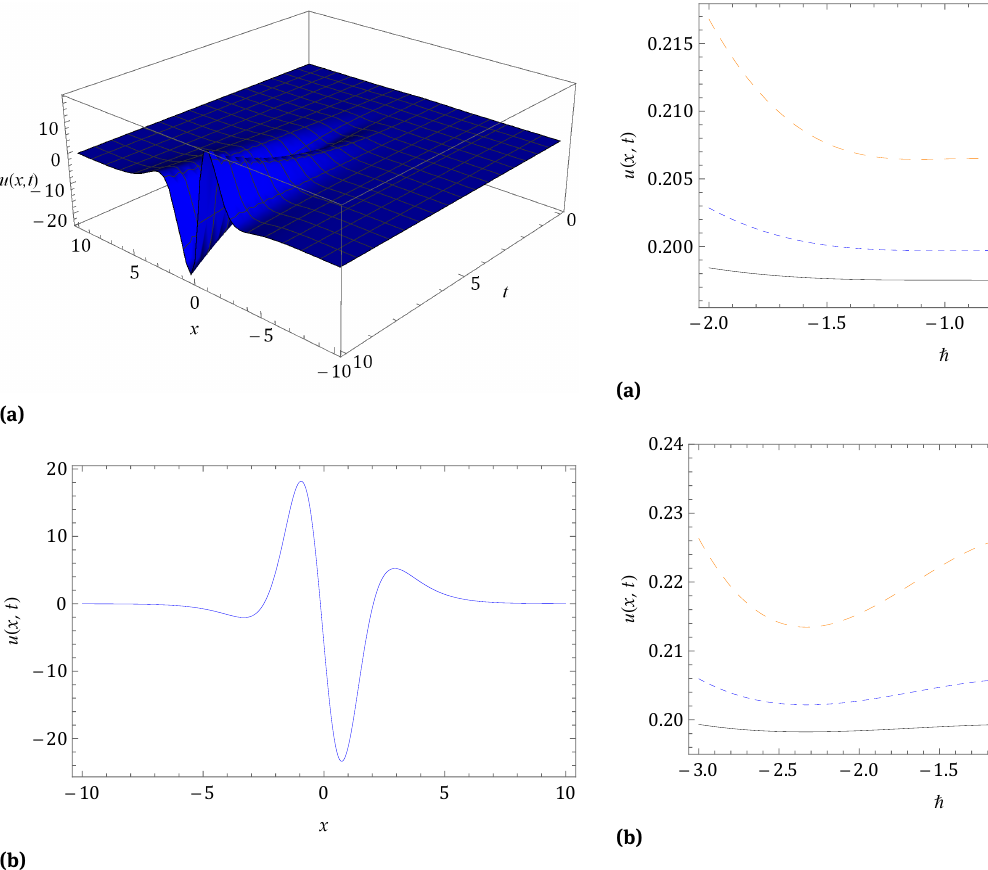
Figure 4: (cid:125) -curves for q -HATM solution with distinct α at x = 1 and t = 0.01 for ( a ) n = 1 and ( b ) n = 2